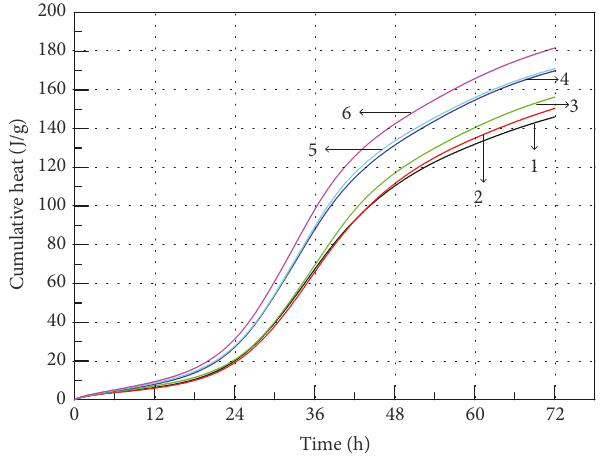
Figure 15: Cumulative heat versus time of references with SCA.